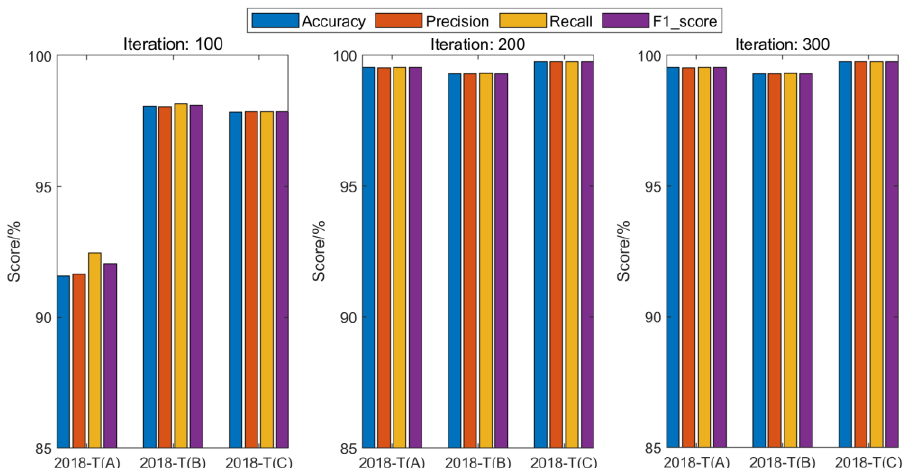
Figure 14. XGBoost performance using raw sample sets with different iteration numbers.